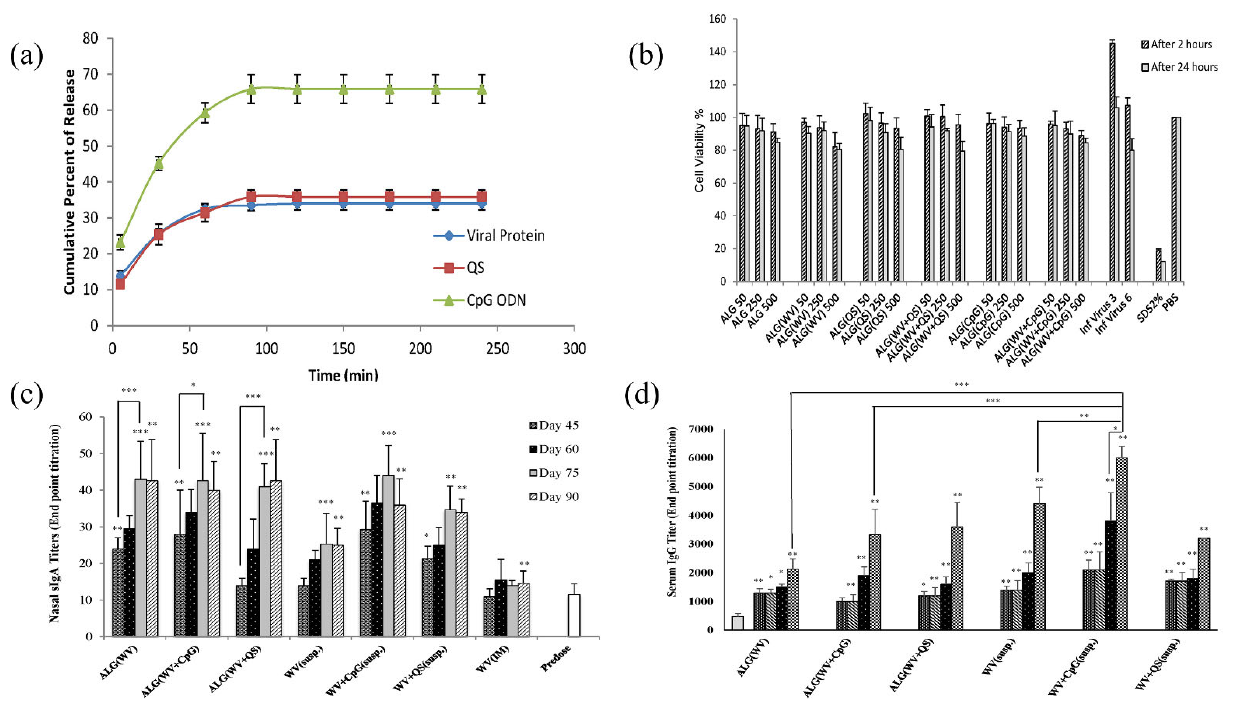
Figure 8. Preparation, characterization, and immunological evaluation of ALG nanoparticles loaded with whole inactivated influenza virus: Dry powder formulation for nasal immunization in rabbits ( a ) % of viral protein, QS, and CpG ODN released in vitro from ALG NPs over four hours. ( b ) After 2 ‐ and 24 ‐ h exposure with varying concentrations of each formulation, the effect of ALG NPs and influenza virus suspension on cell viability in Calu ‐ 6 cell lines ( c ) HAI antibody titers in each vaccination group on day zero (control), day 45 (after prime dose), day 60 (after the second dose), day 75 (after the third dose), and day 90 (after the final booster) ( d ) IgG titers in blood samples taken from each vaccinated cohort on days zero (negative control), 45 (prime dose), 60 (second dose), 75 (third dose), and 90 (after the final booster). * means p < 0.05, ** means p < 0.01, *** means p < 0.001. Reproduced with permission from [220], Copyright Elsevier 2019.